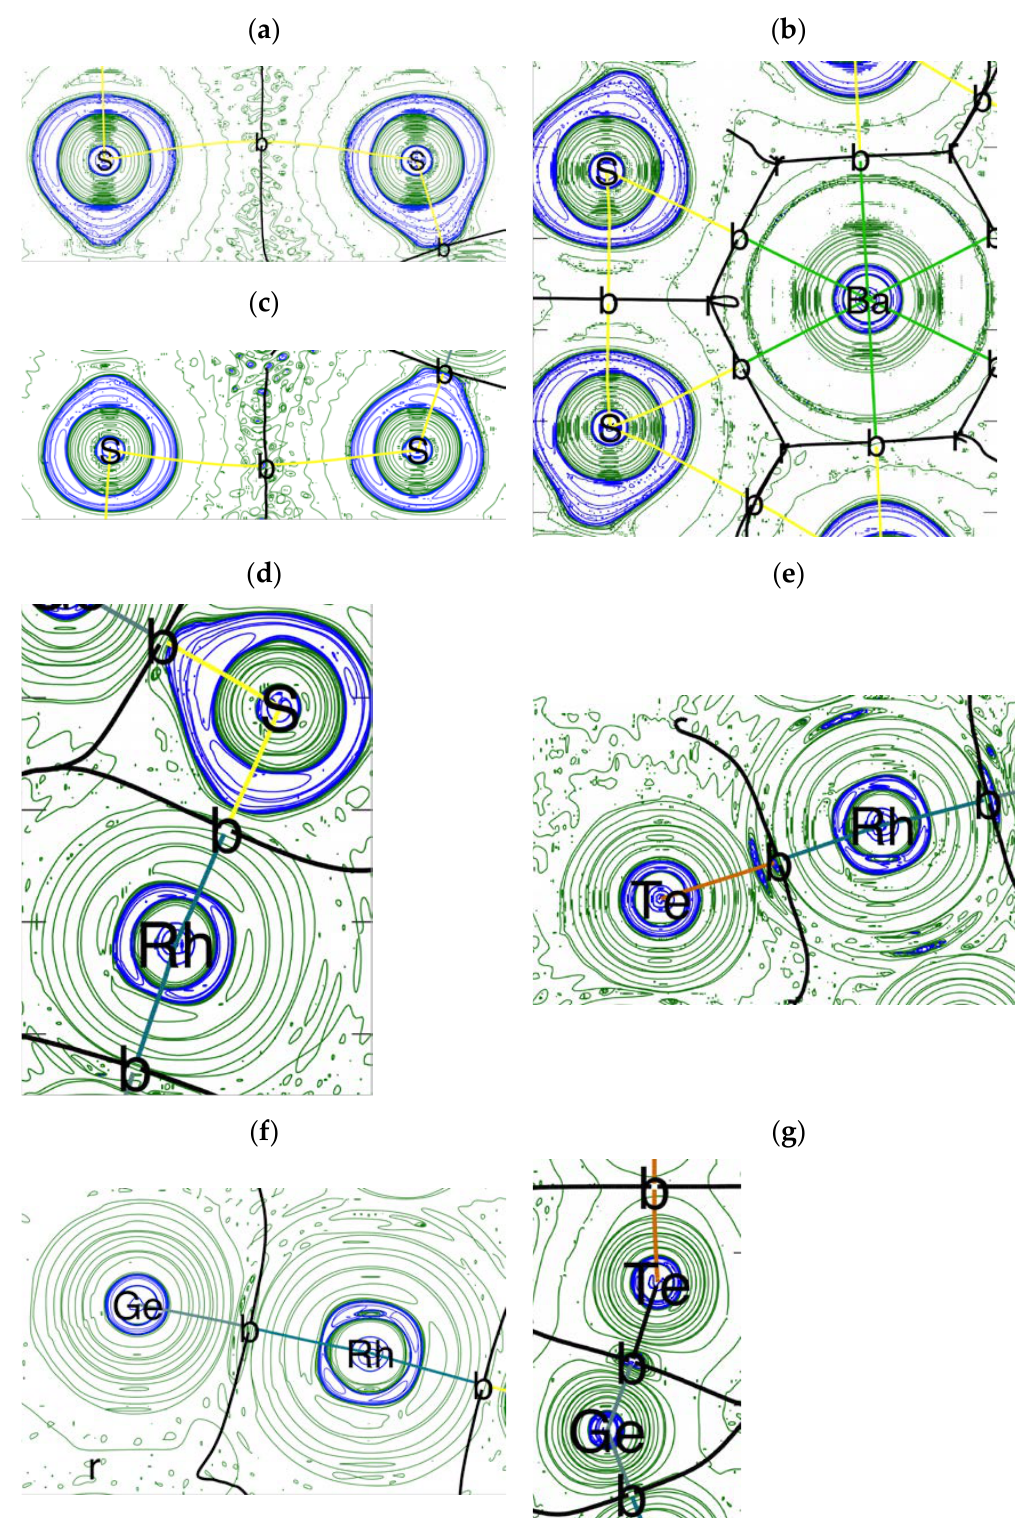
Figure 11. Valence-shell charge concentration (VSCC) of selected pairs of interacting atoms. ( a ) S-S in BaRh 2 Ge 4 S 6 ; ( b ) Ba-S in BaRh 2 Ge 4 S 6 ; ( c ) S-S in BaRh 2 Ge 4 S 4 Te 2 ; ( d ) Rh-S in BaRh 2 Ge 4 S 6 ; ( e ) Te-Rh in BaRh 2 Ge 4 S 4 Te 2 ; ( f ) Rh-Ge in BaRh 2 Ge 4 S 6 ; ( g ) Ge-Te in BaRh 2 Ge 4 Te 6 . Electron density depletion in green; electron density accumulation in blue.